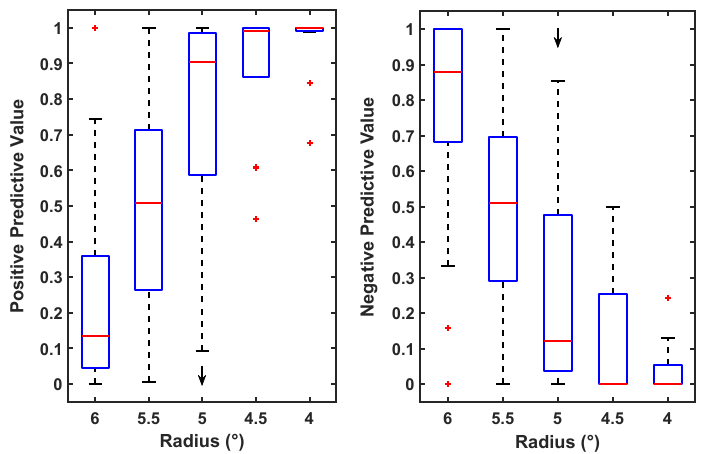
Figure 7. Bar plots of positive and negative predictive values of all subjects across different scotoma radii. The black arrow inside the box plots indicates the point from which a plateau is starting to emerge. The plateau is starting to emerge at 5°.